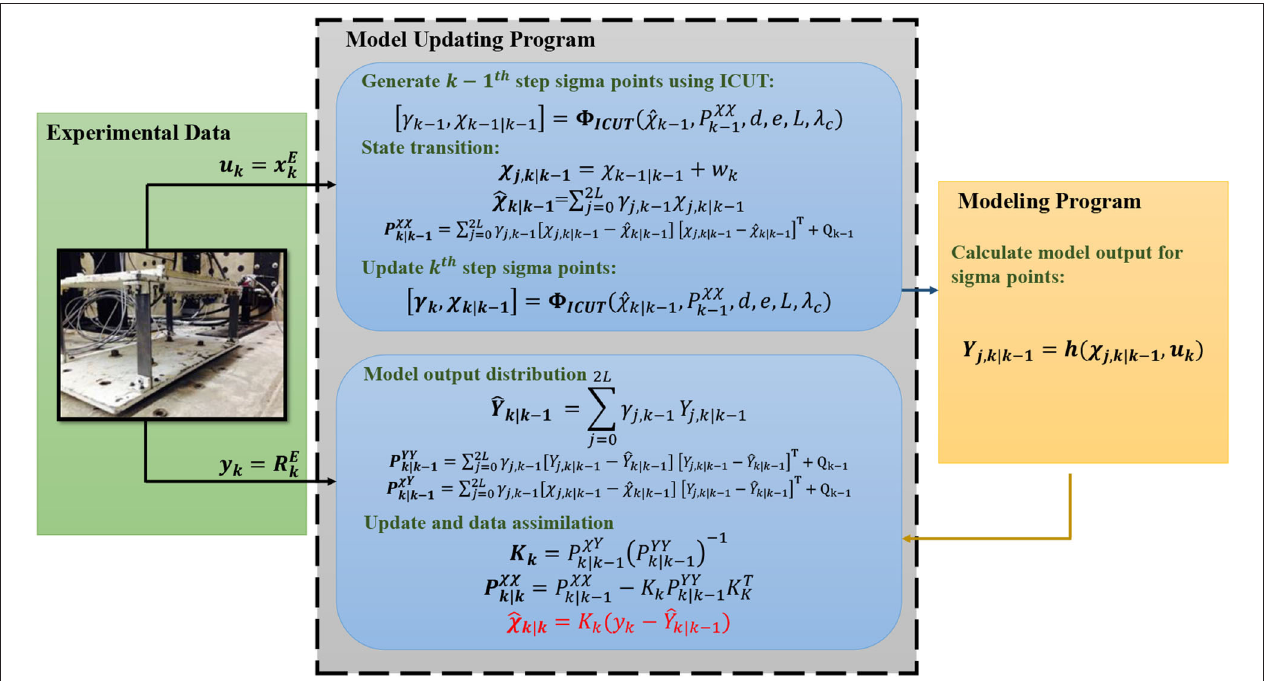
FIGURE 1 | Model updating as implemented in hybrid simulation platform.